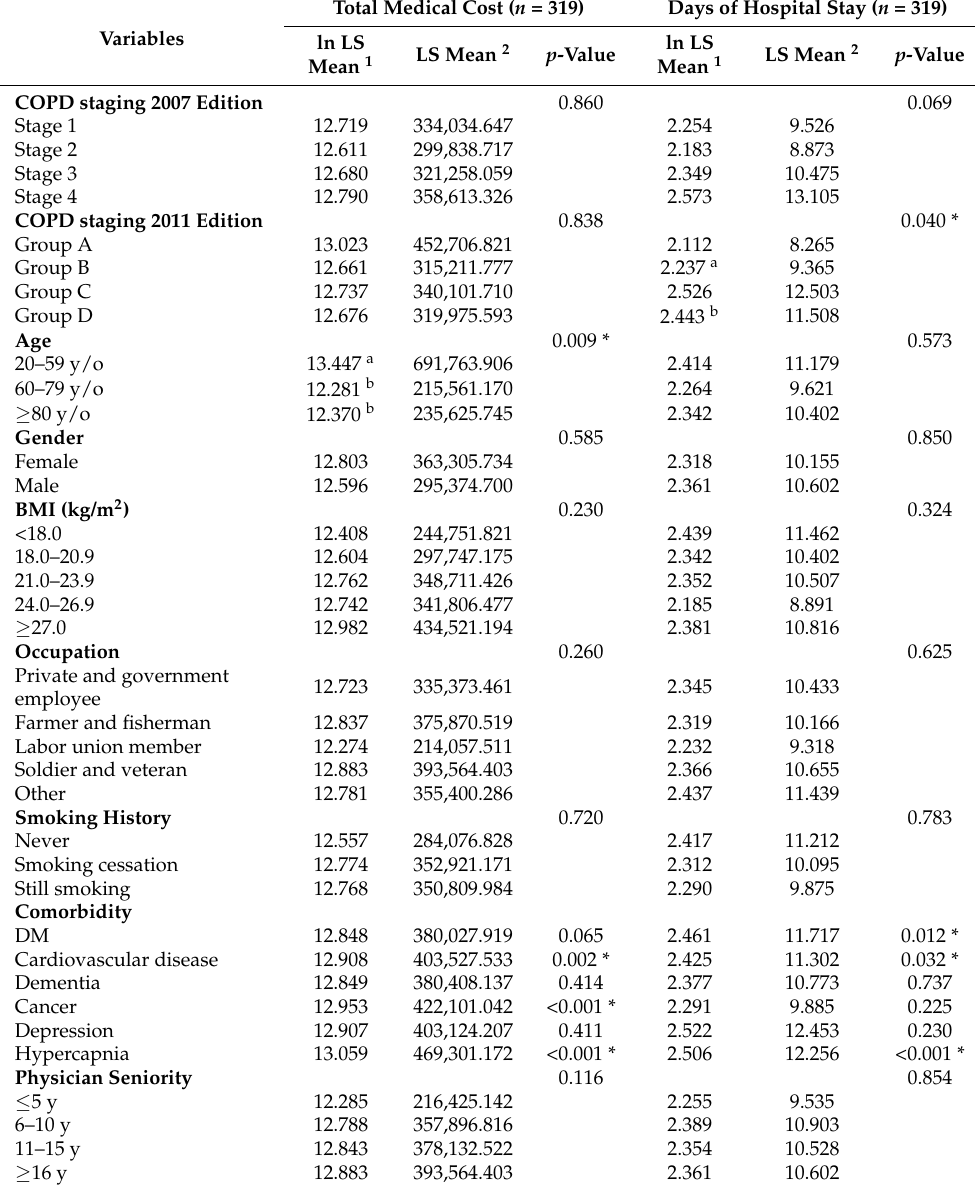
Table 3. General linear model of total medical cost and days of hospital stay in COPD